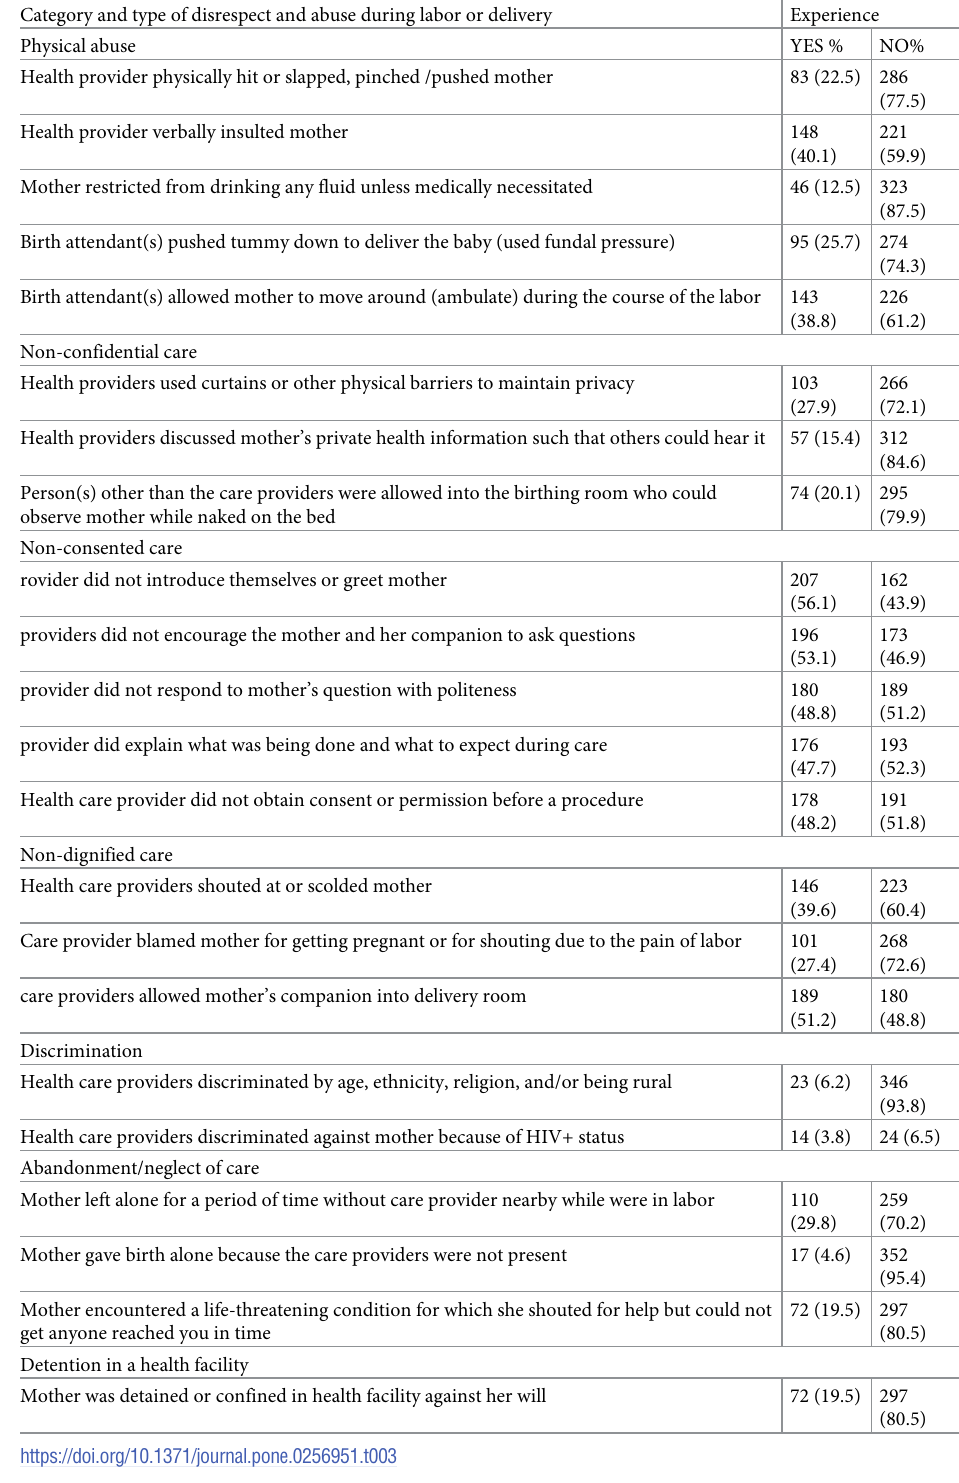
Table 3. Magnitude of disrespect and abuse by verification criteria during facility-based childbirth in Borena Dis- trict, South Wollo, Amhara region, Ethiopia, 2020 (n = 369). Category and type of disrespect and abuse during labor or